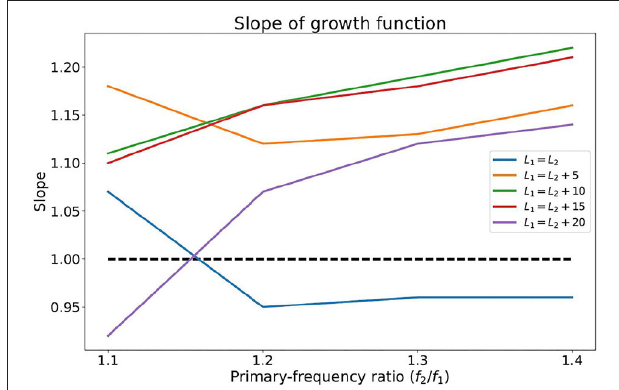
FIGURE 4 | The slope of the growth functions of the IMD3 shown in Figure 3 with various primary-frequency ratios and primary-level differences.